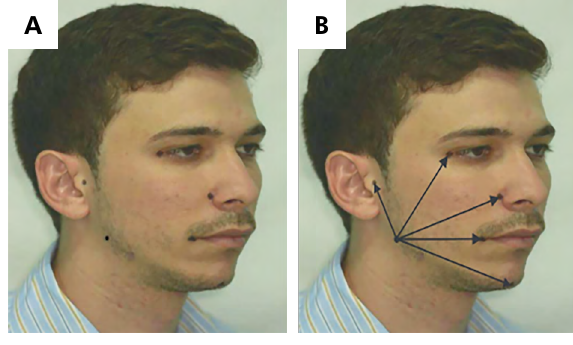
Figure 2. A - Lateral view of craniofacial landmarks (mandibular angle, tragus, nasal wing, outer corner of the eye, labial commissure and chin). B - Lateral view of linear measurements taken from the mandibular angle to other facial